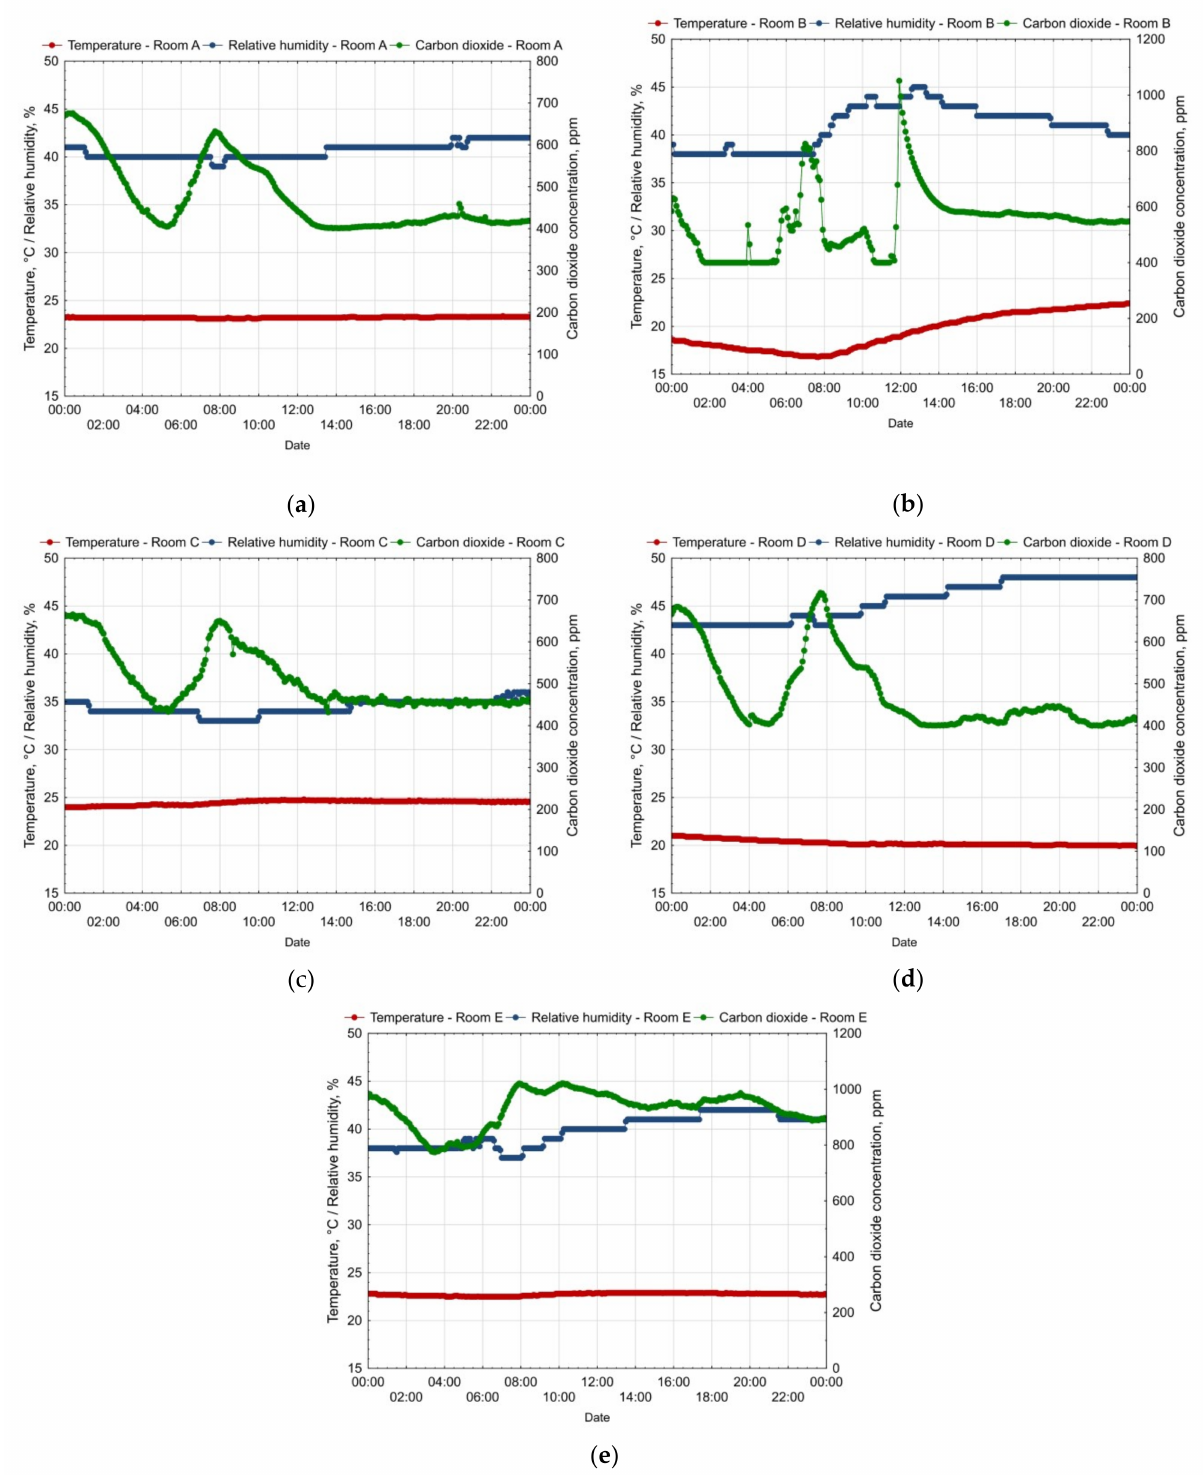
Figure 5. Example of the daily variability of the tested parameters for each room: ( a ) Room A; ( b ) Room B; ( c ) Room C; ( d ) Room D; and ( e ) Room